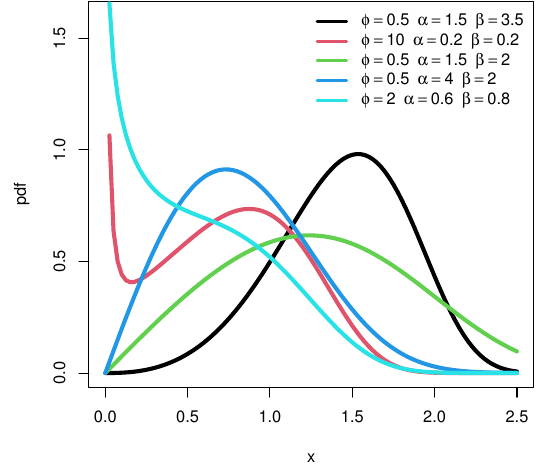
Figure 1. Panels of curves of f ( x ) for diverse values of the parameters.